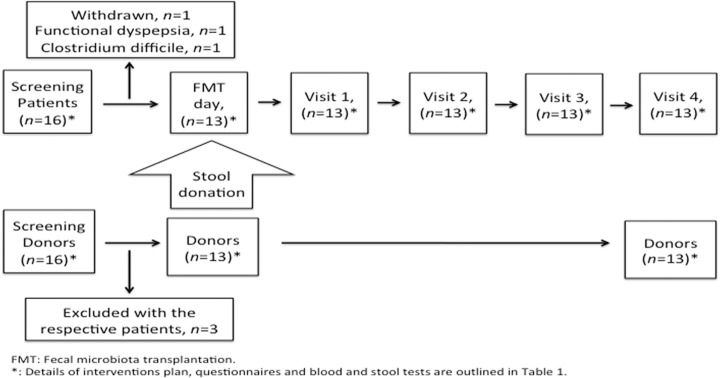
Study flow chart.